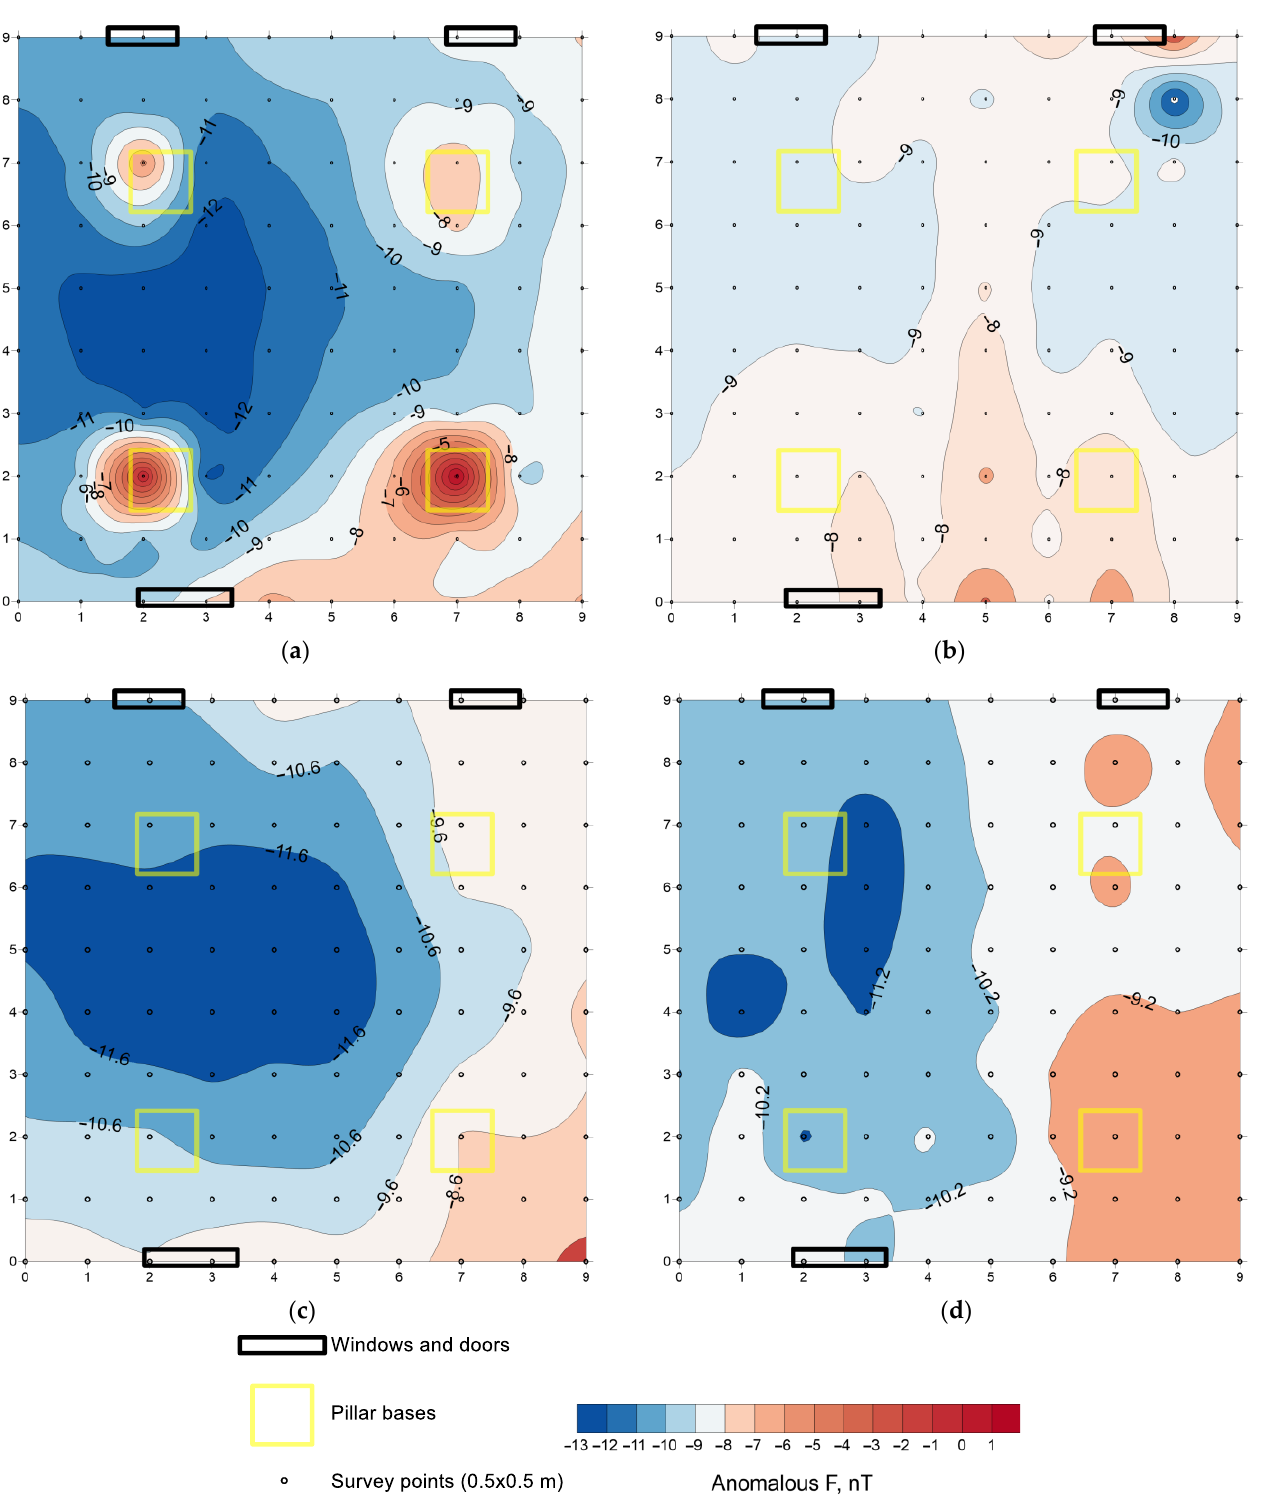
Figure 5. Magnetic field survey results in the absolute pavilion of the Mikhnevo magnetic observatory: ( a ) Magnetic anomaly map at the floor level before the concrete bases for the pillars were shortened; ( b ) magnetic anomaly map at the level of 1.5 m from the floor before the concrete bases for the pillars were shortened; ( c ) magnetic anomaly map at the floor level after the concrete bases for the pillars were shortened; ( d ) magnetic anomaly map at the level of 1.5 m from the floor after the concrete bases for the pillars were shortened.